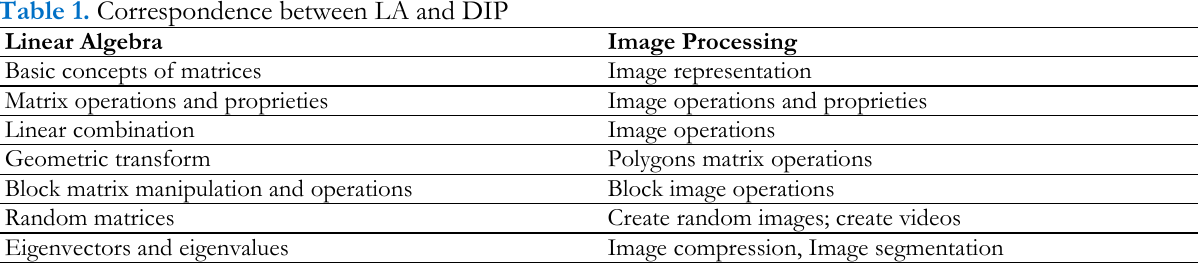
Table 1. Correspondence between LA and DIP Linear Algebra Image Processing Basic concepts of matrices Image